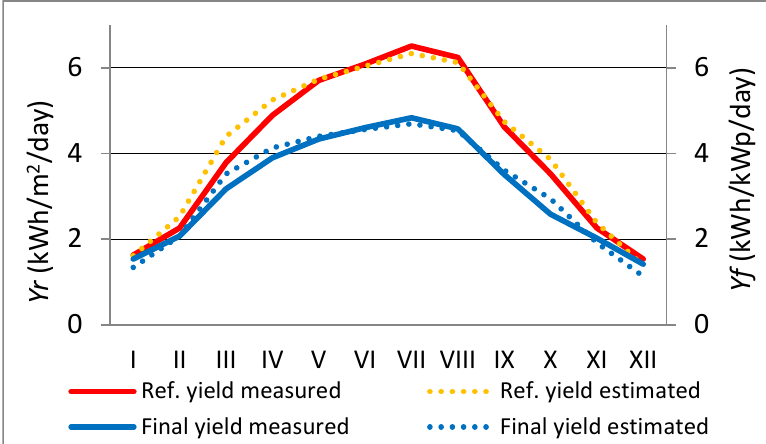
Figure 4. The final and reference yield daily average for the 8 years of operation.